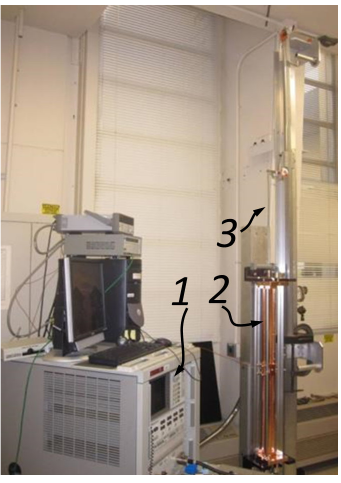
FIG. 8. Setup for microwave measurement and tuning: 1: vector network analyzer; 2: rf deflector; 3: reflective plunger.